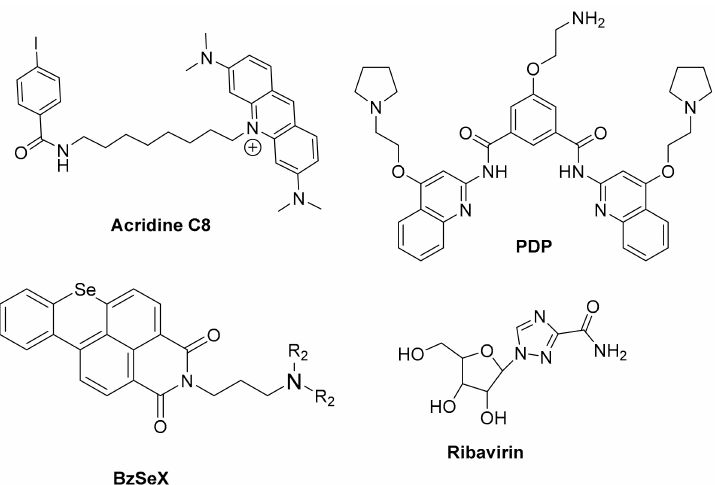
Figure 7. Structures of other G4 ligands with antiviral